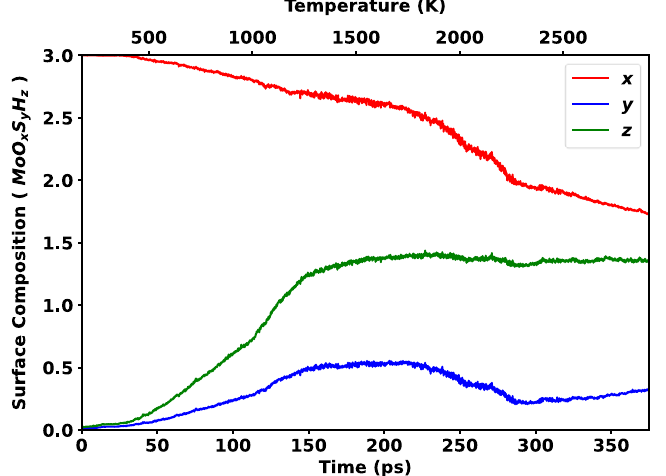
Figure 4. Rate of reduction process. The red, blue and green curves represent the changes in composition of oxygen, sulfur and hydrogen atoms on the surface on the MoO x S y H z surface. The reduction was observed until 375 ps raising the temperature up to 2800 K.